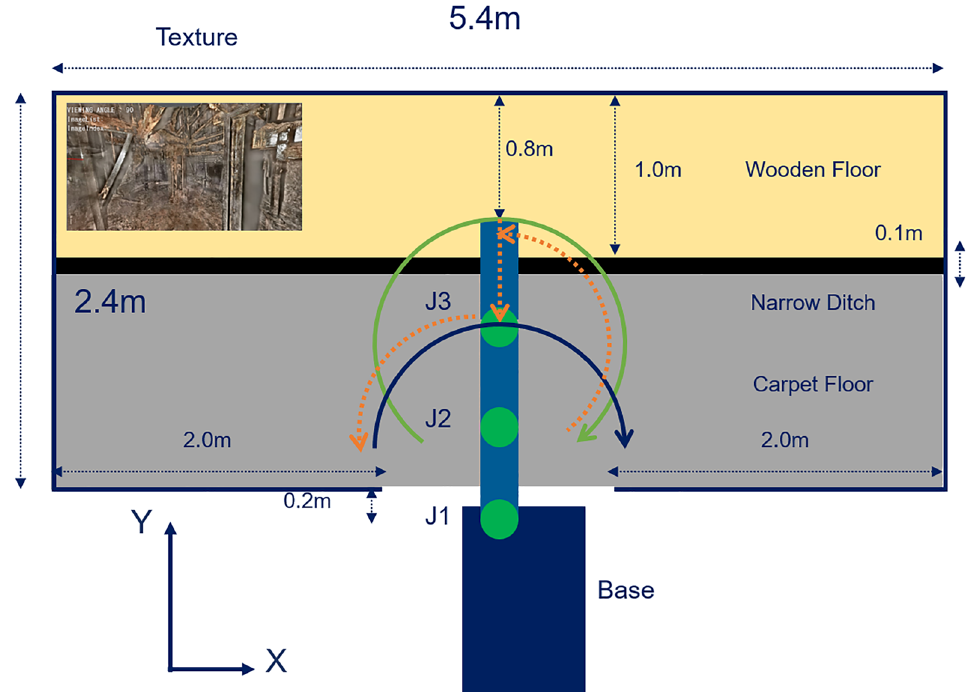
Fig. 11 The environment setup for the reconstruction experiment. Green: Trajectory #1; Orange: Transition; Blue: Trajectory